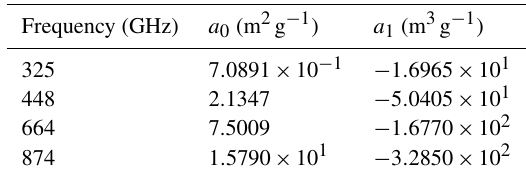
Table A1. Coefficients in the fitting of terahertz mass